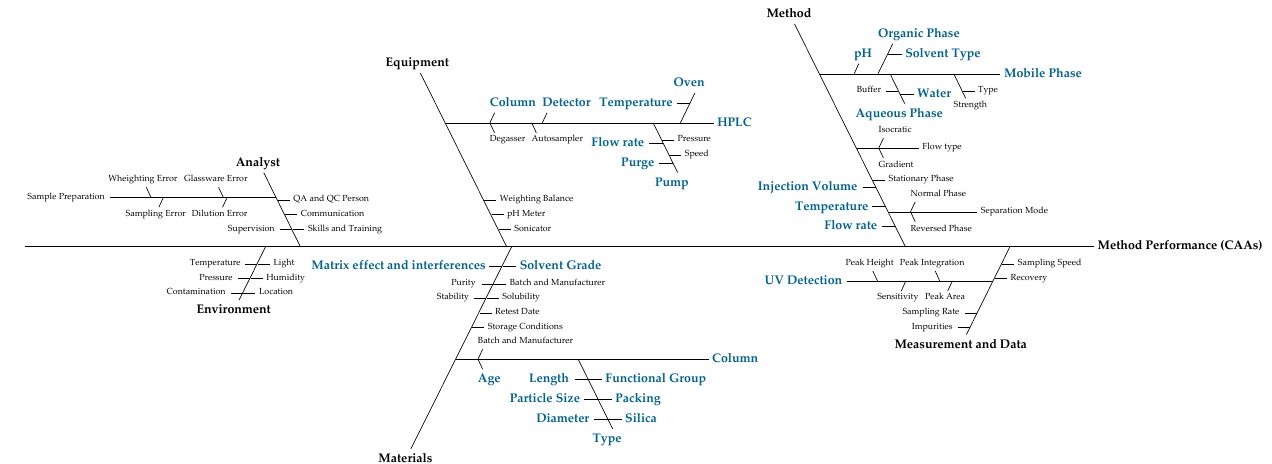
Figure 4. Ishikawa diagram highlighting potential parameters that influence method performance. Parameters further evaluated by FMEA are outlined in blue. QA: Quality assurance; QC: Quality control.